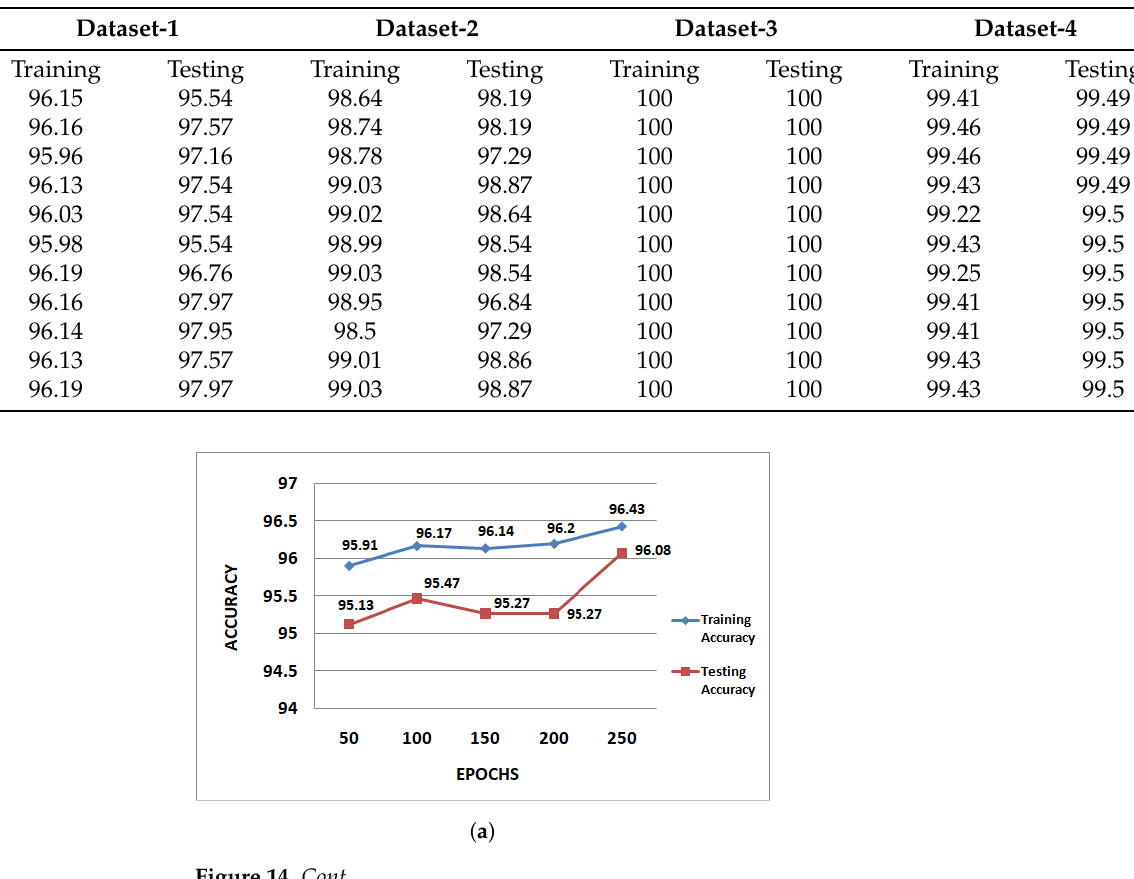
Table 7. Training and testing accuracy on various simulation runs.